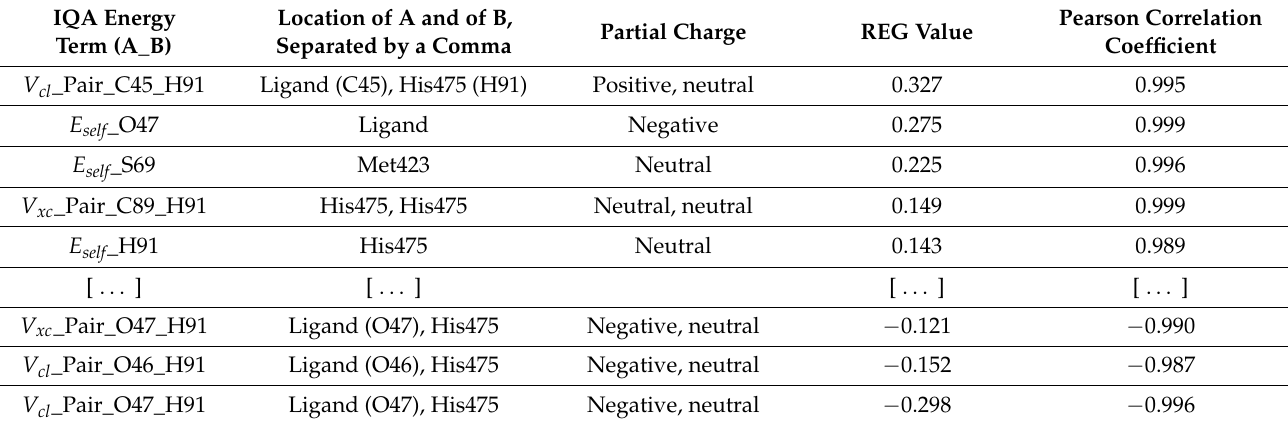
Table 3. The top pairwise interaction terms ( A-B ranking) for segment 1 of 3CJ4, in favour of